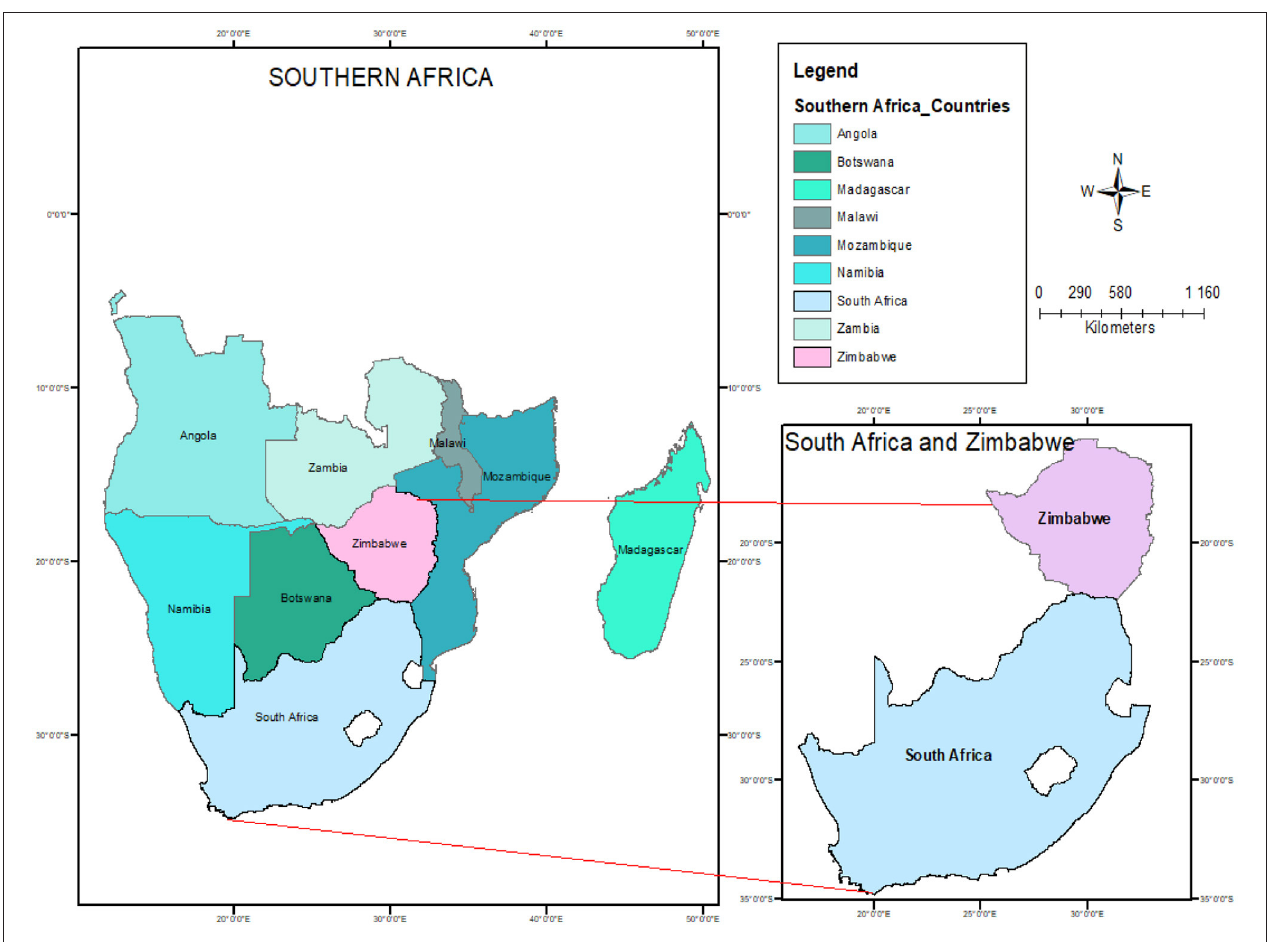
FIGURE 1 | Map of Southern Africa. Source: Author